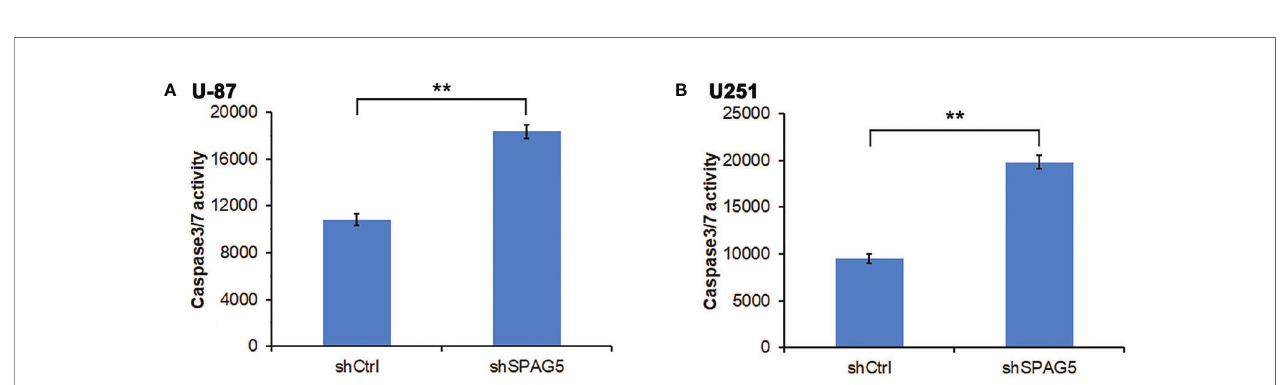
FIGURE 5 | Measurement of apoptotic cells under sperm-associated antigen 5 (SPAG5) downregulation in (A) U-87 cells and (B) U251 cells. Results are to calculate the percentage of Caspase 3/7-positive cell population. Results were expressed as mean ± SD from three independent experiments. ** P <